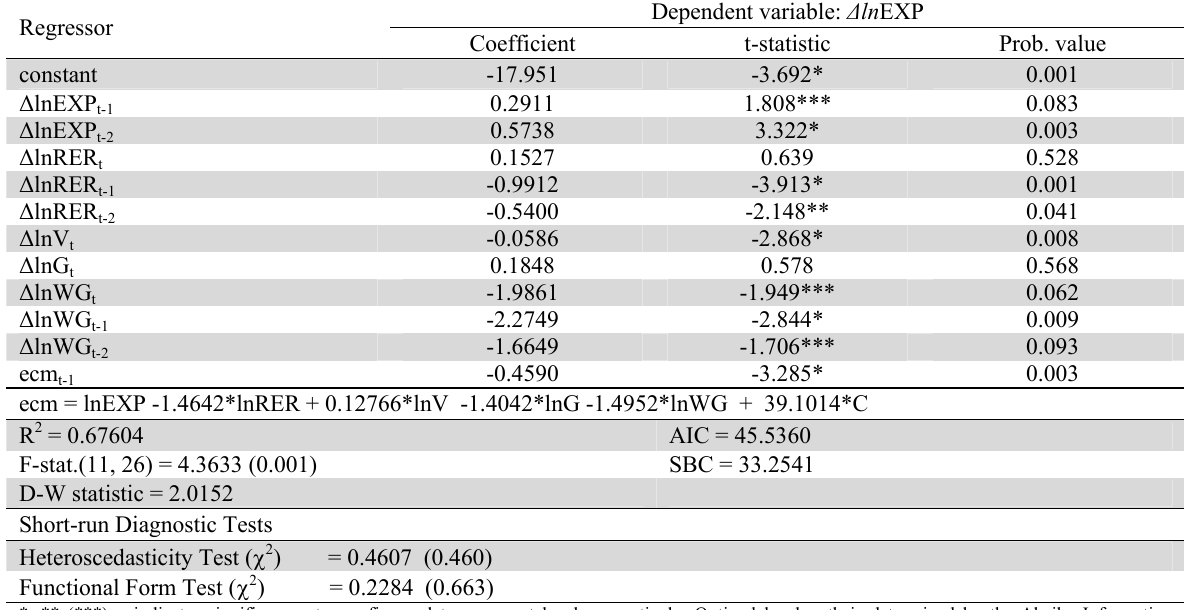
Error Correction Representation for the Selected ARDL (3,3,0,1,3) Model